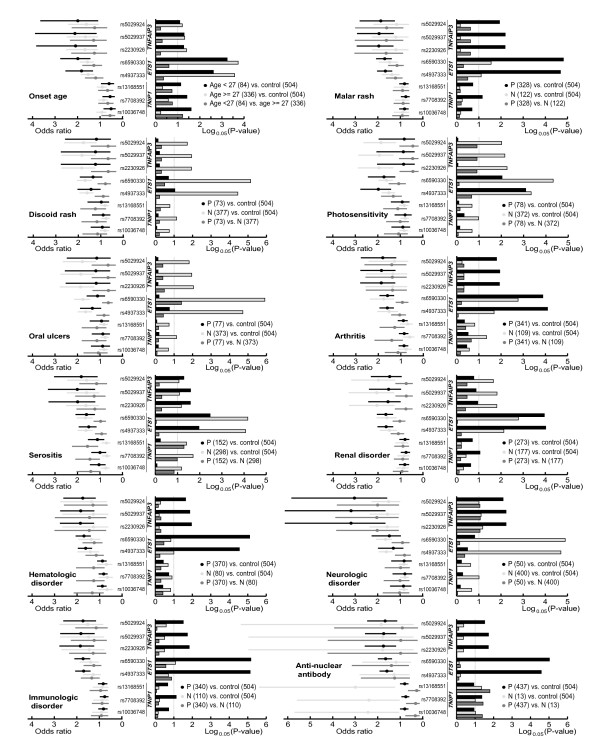
Associations of TNFAIP3, ETS1 and TNIP1 with systemic lupus erythematosus assessed by stratified analysis. P, patient group with a certain subphenotype; N, patient group without the subphenotype. Number in parentheses is the sample size. Vertical dashed line in each subphenotype panel indicates the cutoff value of statistical significance (P = 0.05).